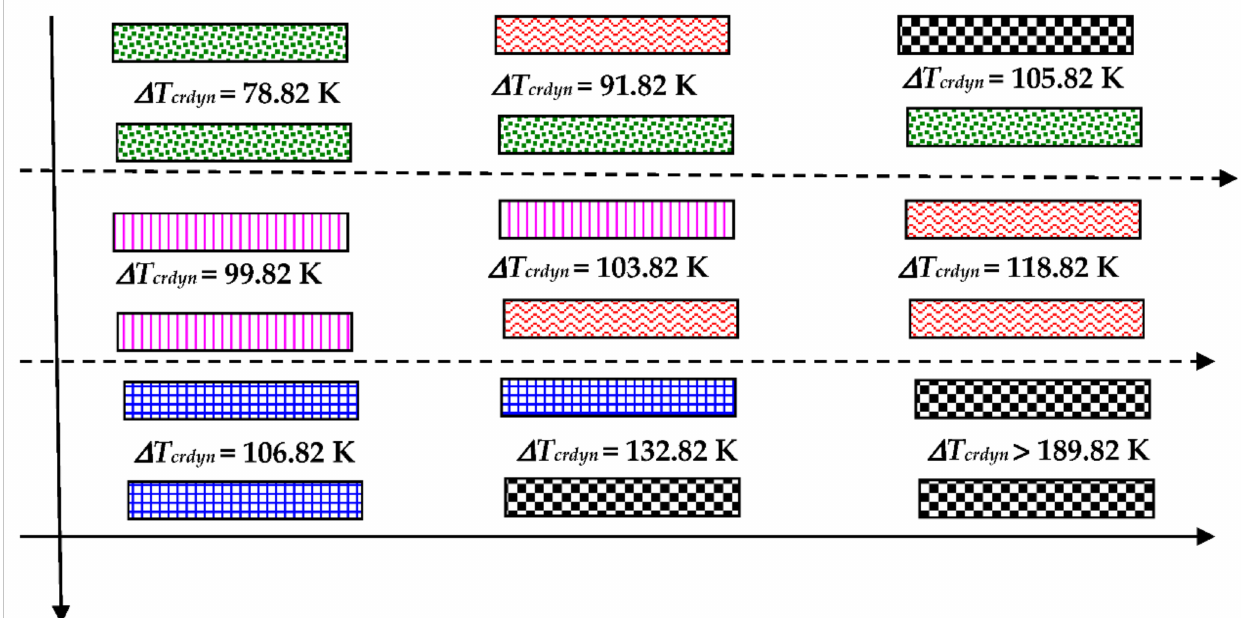
Figure 12. Distribution of the values of critical, dynamic temperature differences ∆ T crdyn depending on the form of the Scheme 13. Time histories of deflection and velocity of deflection of the damaged FEM plate model with laminate matrices